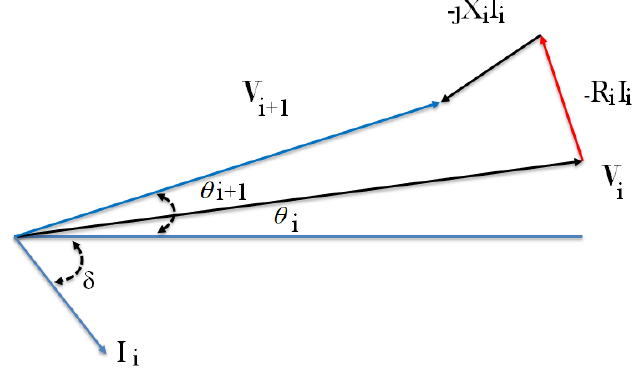
Figure 14. HFC D-STATCOM Phasor technique structure installation in feeder 𝑖 + 1 . By taking into consideration the real and imaginary sections is from Equation (1), 𝑋 = −𝐵 ± √∆ 2𝐴